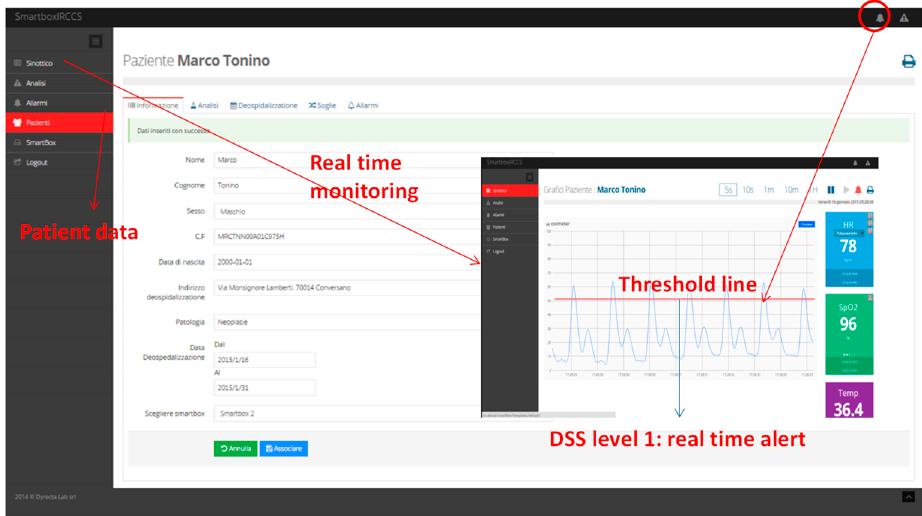
Figure 7. Control room panel layout: DSS level 1.